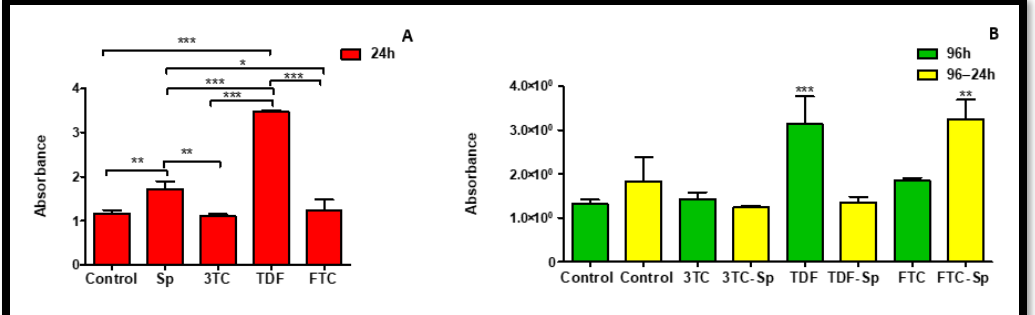
Figure 9. Effects of SP and HAART (3TC, TDF, and FTC) on intracellular LDH levels. Intracellular LDH levels after exposure of HepG2 cells to ( A ) SP and HAART for 24 h, ( B ) HAART (96 h), and HAART (96 h) followed by SP (24 h); * p < 0.05, ** p < 0.005, *** p < 0.0001.